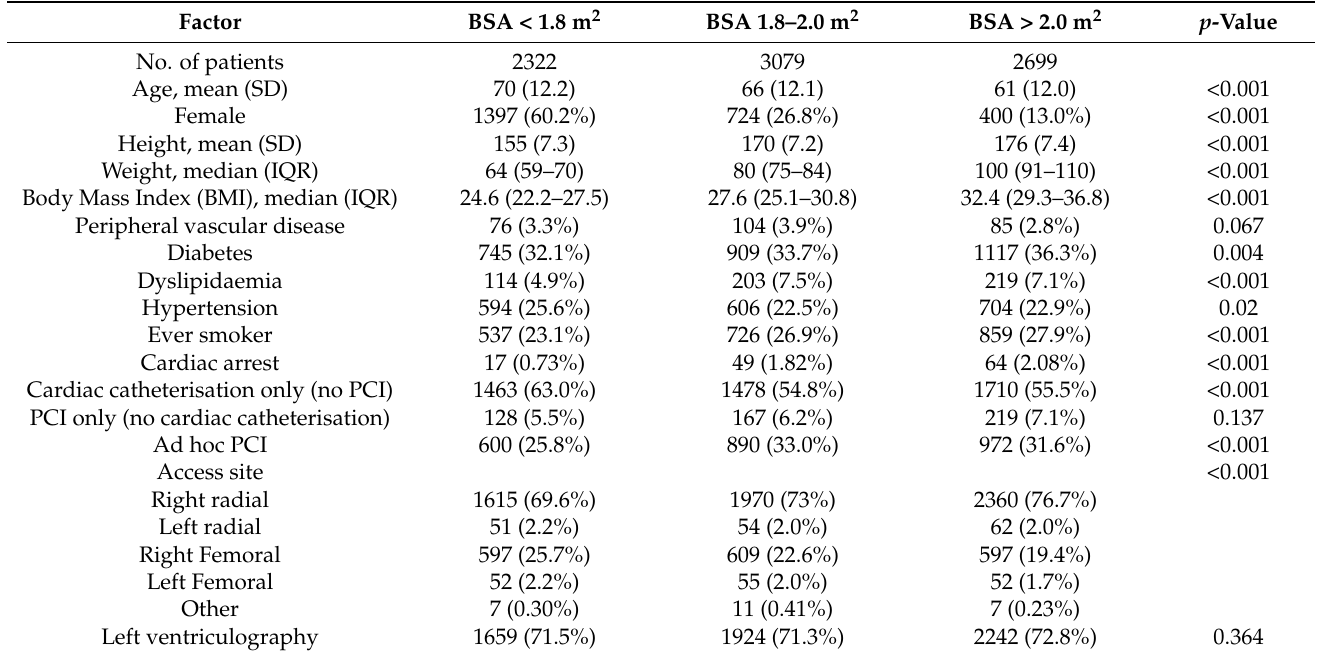
Table 1. Baseline characteristics for whole cohort, analysed by body surface area categories. Both patient and procedural characteristics are